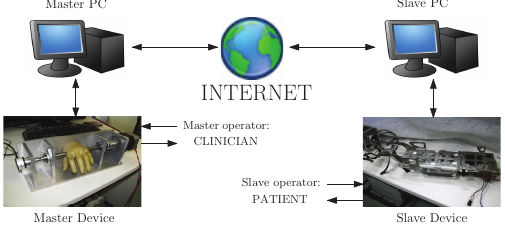
Figure 1. A simplified scheme of the teleoperation control system